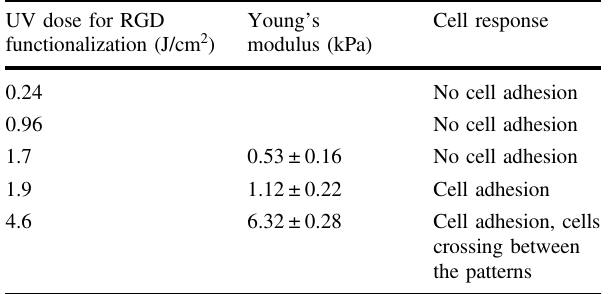
Table 3 Cell adhesion and proliferation on different RGD-peptide sequences Peptide